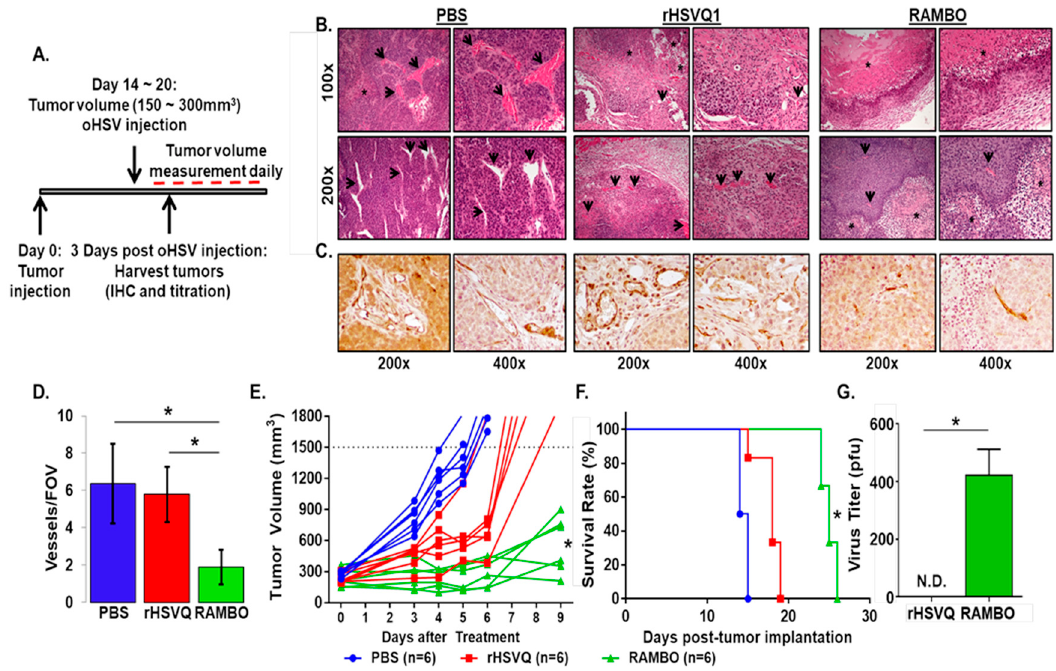
Figure 5. RAMBO virus reduces angiogenesis and enhances antitumor efficacy in sarcoma xenografts. ( A ) Schematic representation of animal study. All animal studies were conducted in the same way as shown in ( A ) except the time of tumor harvest. ( B ) Evaluation of antitumor and anti-angiogenic activity of RAMBO in vivo. Subcutaneous A673 sarcoma tumor-bearing mice were treated with PBS, rHSVQ or RAMBO and sacrificed three days after the virus treatment to harvest their tumor tissues for histological analysis. Hematoxylin and Eosin (H&E) staining was done on tumor tissues to compare areas of necrosis between treatment groups. Black arrows indicate endothelial cells and asterisks (*) indicate areas of necrotic tissue. ( C ) Representative images of tumor sections stained with CD31 antibody. Note significant reduction in CD31 positive tumor vasculature after RAMBO treatment compared to rHSVQ or PBS controls ( n = 3/group). ( D ) Quantification of CD31 immunostained vessels per field of view in the tissue sections from treated sarcoma tumors was examined between treatment groups. Data shown are average vessel density per field of view of ×400 (FOV) ± SD (* p < 0.05). ( E ) Tested the antitumor efficacy of RAMBO in A673 sarcoma-bearing mice xenografts. Athymic nude mice with subcutaneous A673 sarcoma tumors were injected with rHSVQ1, RAMBO, or PBS by intratumoral injection when the A673 tumor volumes reached an average size of 150–300 mm 3 , and then tumor growth was measured daily. ( F ) Mice were sacrificed when tumor volume reached ≥ 1500 mm 3 and mice survival was analyzed by Kaplan–Meier survival curve. ( G ) A673 tumors treated with HSVQ or RAMBO were harvested 3 days post virus treatment and dissociated and processed for titration. Viral titers were measured by standard plaque forming unit assay on Vero cells and compared between HSVQ and RAMBO infected tumors. N.D., not determined; * p < 0.05.